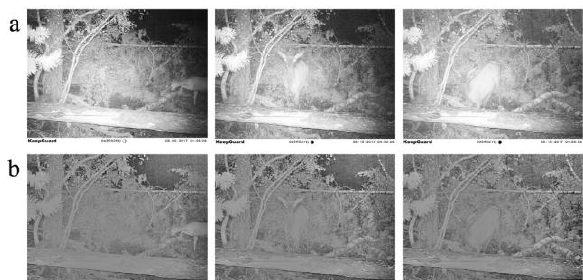
Figure 3. Example of illumination enhancement of day images subset: a) original images, b) processed images